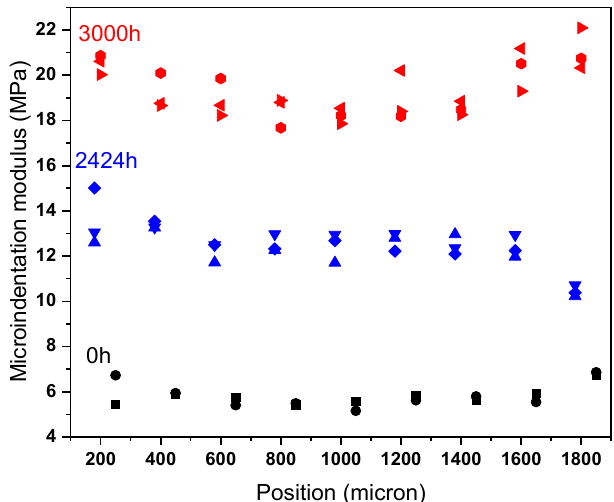
Figure A1. Evolution/profile of modulus through the thickness measured by microindentation of a 2 mm-thick sample aged at 90 °C for different durations.